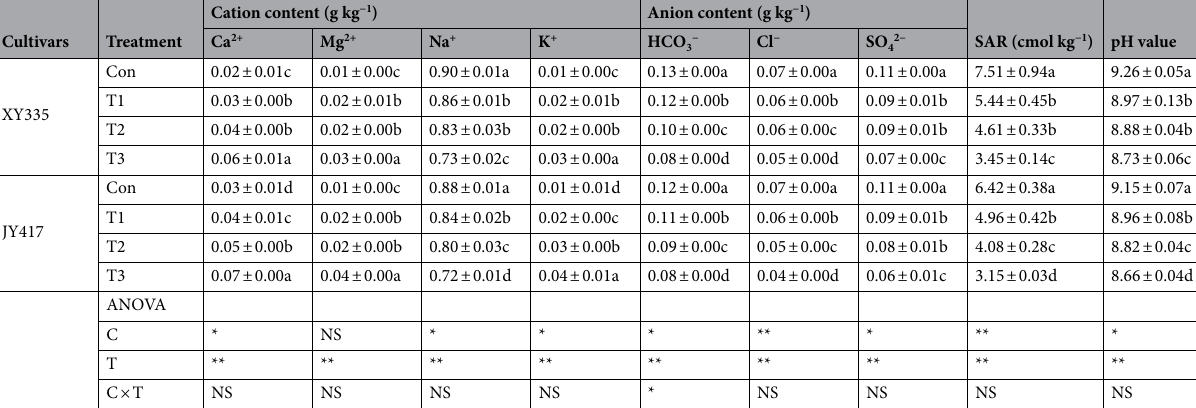
Table 1. Influence of T. asperellum on salt ion content, sodium adsorption ration (SAR), and pH value of maize seedlings rhizosphere soil (± SD). Con, T1, T2, and T3 indicate 0, 1 × 10 3 , 1 × 10 6 , and 1 × 10 9 spores L −1 suspension, respectively. Soil salt ion content, SAR, and pH were measured on the 27th day after T. asperellum application. C and T indicated cultivars and treatments, respectively. Different letters within a column indicated significant differences at 5% probability level, and the numerical value represented the mean value of five repeats. Differences between treatments were calculated for each particular cultivar. NS, not significant. * and **, significant at the 0.05 and 0.01 probability level,